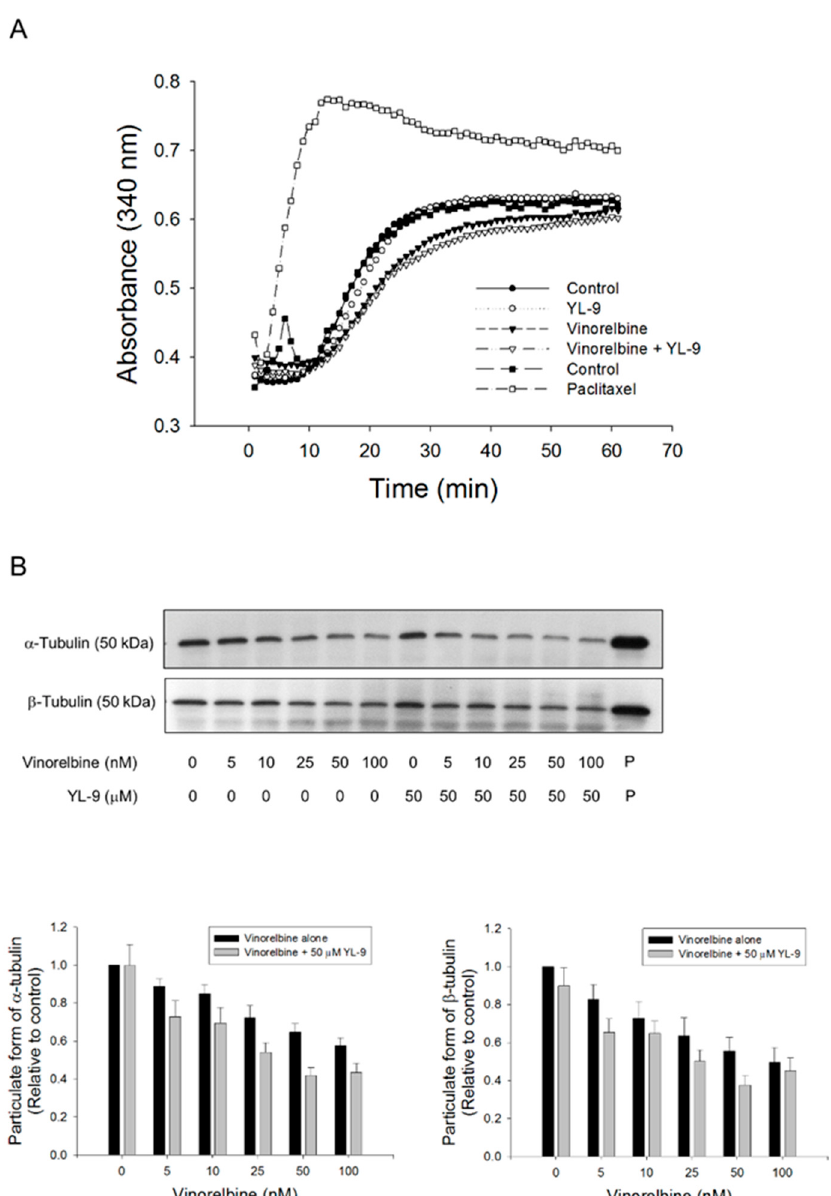
Figure 6. Effect of YL-9 on vinorelbine-induced alteration of tubulin polymerization. ( A ) Tubulins were incubated in the absence or presence of YL-9 (50 μ M) or vinorelbine (1 μ M) at 37 °C for 1 h. The levels of tubulin polymerization were detected using ELISA reader at 340 nm absorbance. Positive control, 30 μ M paclitaxel. ( B ) NCI-H460 cells were incubated in the absence or presence of YL-9 or vinorelbine for 6 h. The cells were harvested for the detection of tubulin polymerization (particulate form of tubulin) using Western blotting analysis. The expression was quantified using Bio-Rad Image Lab TM Software. The expression is relative to compound-free control. Data are expressed as mean ± SEM of eight independent experiments. P, paclitaxel as positive control.